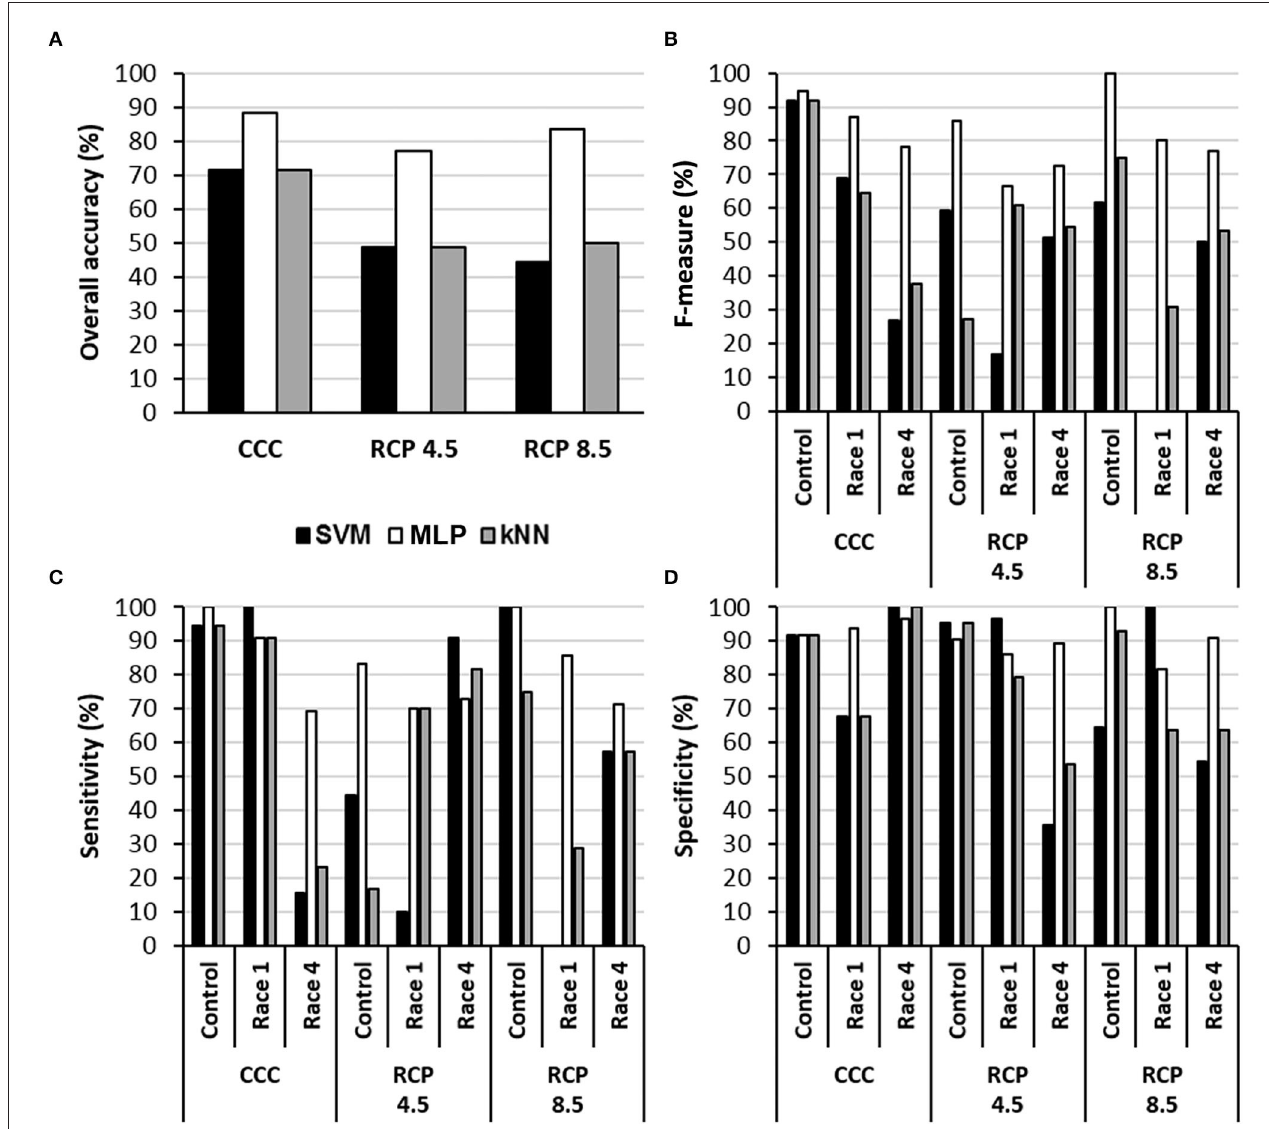
FIGURE 3 | Performance of three algorithms for the classification of samples into the categories control, Xcc race 1-infected, and Xcc race 4-infected leaves in terms of overall accuracy (A) , F -measure (B) , sensitivity (C) , and specificity (D) for each climate scenario. SVM, support vector machine; MLP, multilayer perceptron-based artificial neural network; kNN, k-nearest neighbors ( k = 5 neighbors). CCC, current climate conditions; RCP 4.5 and 8.5, representative concentration pathways 4.5 and